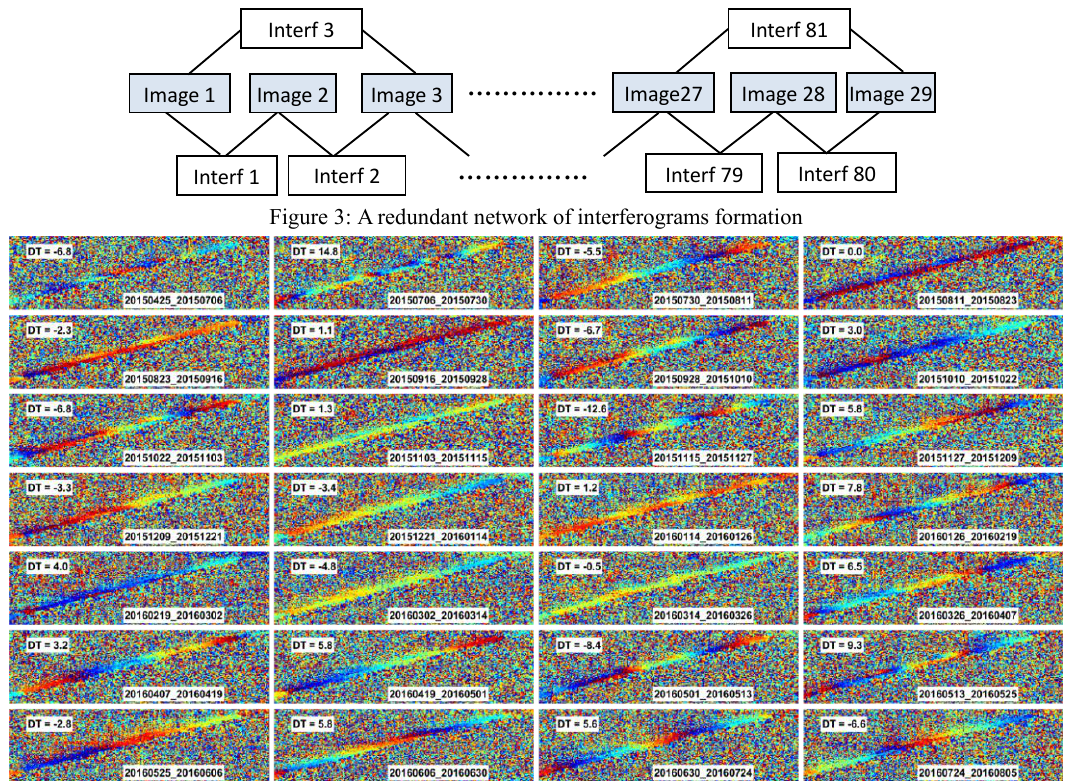
Figure 4: Differential interferograms, dates and temperature